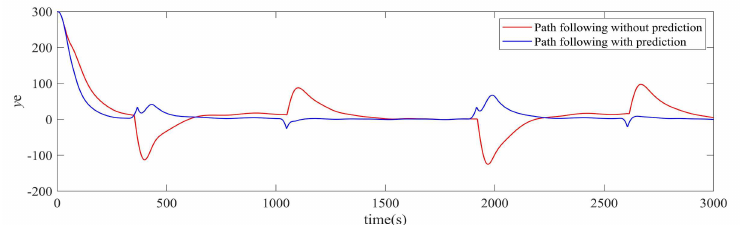
Figure 4. Simulation comparison of ship path following with and without position prediction.